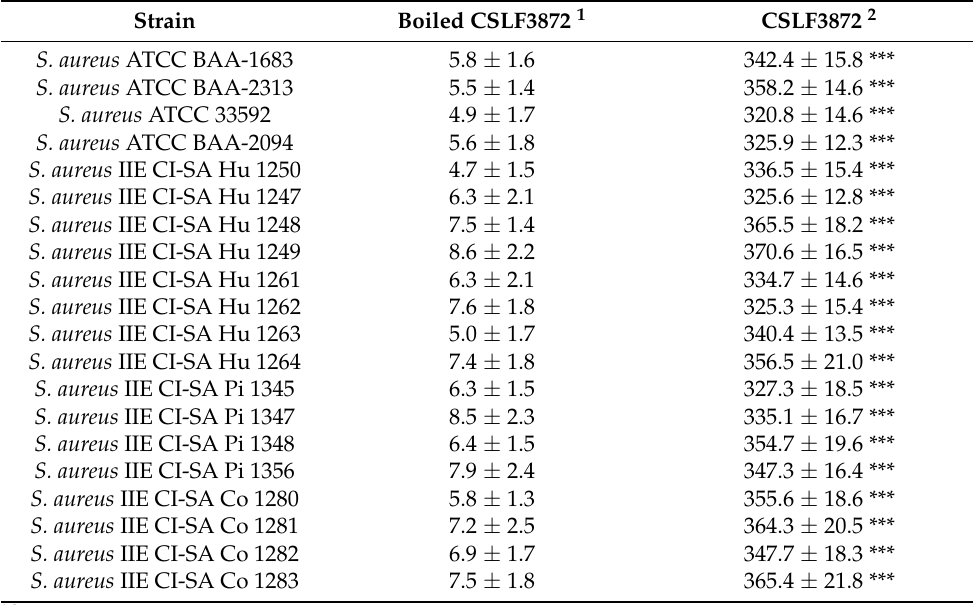
Table 7. Extracellular ATP levels in antibiotic-resistant S. aureus strains treated with CSLF3872.